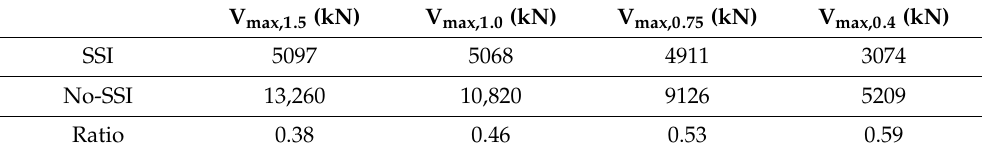
Table 6. Shear at the pier base computed by including vs. neglecting SSI, for the four seismic inputs. V max,1.5